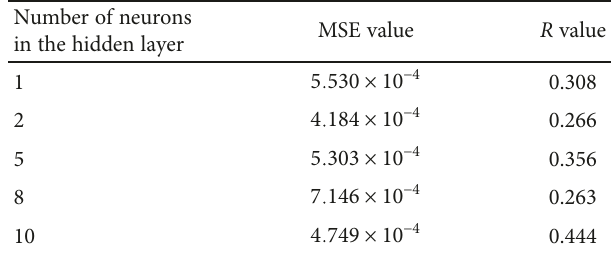
Table 11: Values of MSE and R depending on the number of neurons in the hidden layer in model ANN